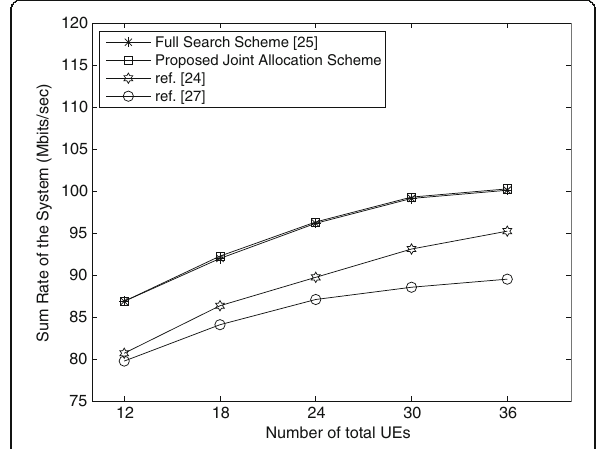
Fig. 8 Comparison of the sum rate of the system, in respect to Fig. 7